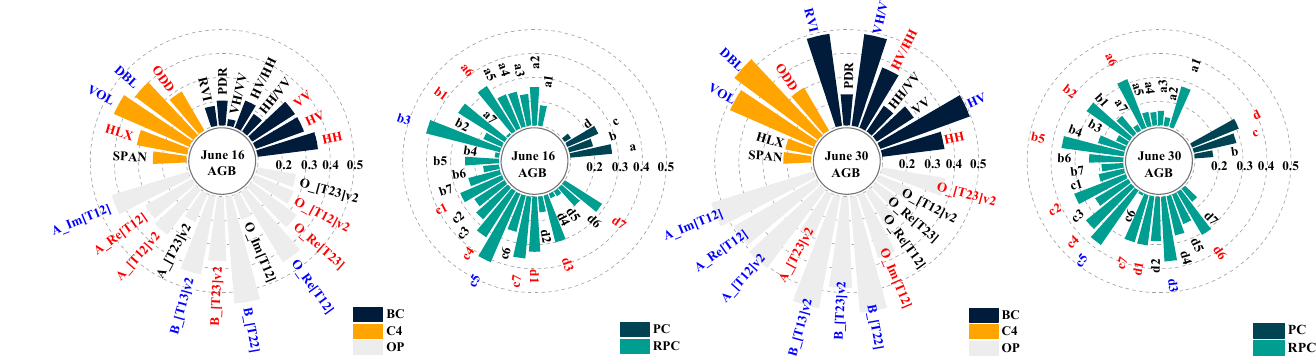
Figure 6. Pearson correlations between forest AGB and polarimatric features acquired on 16 June and 30 June, a, b, c, and d represent four polarization coherences, |𝛾 (cid:3009)(cid:3009)(cid:2879)(cid:3023)(cid:3023) | , |𝛾 (cid:3009)(cid:3009)(cid:2879)(cid:3009)(cid:3023) | , (cid:3627)𝛾 ((cid:3009)(cid:3009)(cid:2878)(cid:3023)(cid:3023))(cid:2879)((cid:3009)(cid:3009)(cid:2879)(cid:3023)(cid:3023)) (cid:3627) , (cid:3627)𝛾 ((cid:3009)(cid:3009)(cid:2879)(cid:3023)(cid:3023))(cid:2879)(cid:3009)(cid:3023) (cid:3627) , 1–7 indicate 𝛾 (cid:3040)(cid:3028)(cid:3051) , 𝛾 (cid:3040)(cid:3036)(cid:3041) , 𝛾 (cid:3040)(cid:3032)(cid:3028)(cid:3041) , 𝛾 (cid:3046)(cid:3047)(cid:3031) , 𝛾 (cid:3040)(cid:3028)(cid:3051)(cid:2879)(cid:3040)(cid:3036)(cid:3041) , 𝜃 (cid:3082) , 𝜃 (cid:3082) (cid:3127)(cid:3288)(cid:3276)(cid:3299) (cid:3127)(cid:3288)(cid:3284)(cid:3289) in each polarization coherences, respectively. (Note: Features in blue are significantly correlated at the 0.01 level; Features in red are significantly correlated at the 0.05 level).